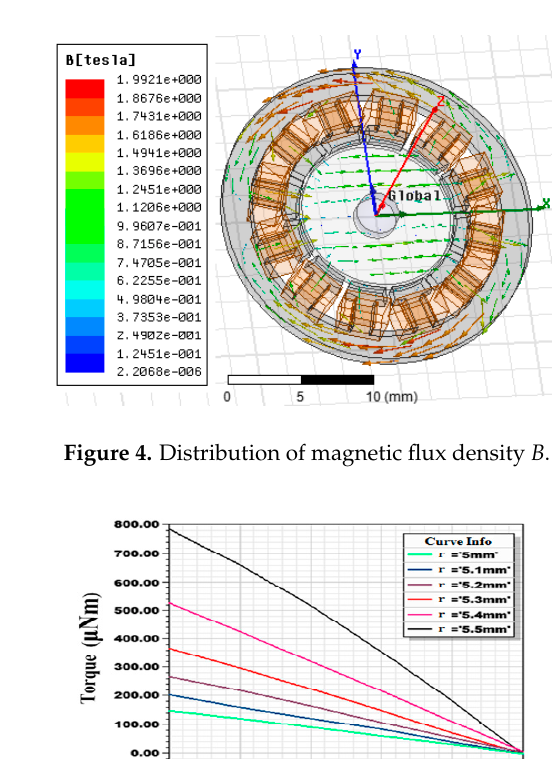
Figure 6. Magnetic self-restoring torque M c for different δ ( φ = 1°). 3.2. Dragging Torque of Water-Film Bearing to Spinning and Precessional Motion According to the slip model of viscous fluids by Spikes [32], tangential stress τ s between the water film and the SHS of the rotor is expressed as: where τ L is the tangential stress limit, which is small in amplitude and omitted, η is the viscosity of the water film, b is the average slip length, and v s is the slip speed. Thus, during spinning motion, drag torque T fs exerted by the water-film bearing on the rotor ball is calculated as: ssLs v bv b